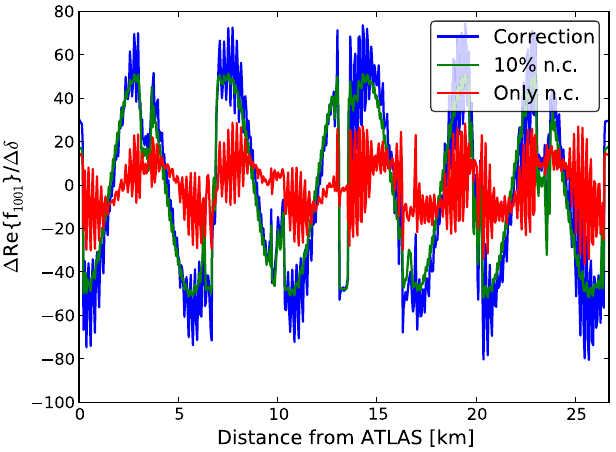
FIG. 5. The chromatic coupling from our model, with correc- tions for normal (skew quadrupoles) and chromatic coupling (skew sextupoles) added. The green line shows the same correc- tors added, but only 10% of the strength in the skew quadrupoles. The red line shows the chromatic coupling coming only from the skew quadrupoles.